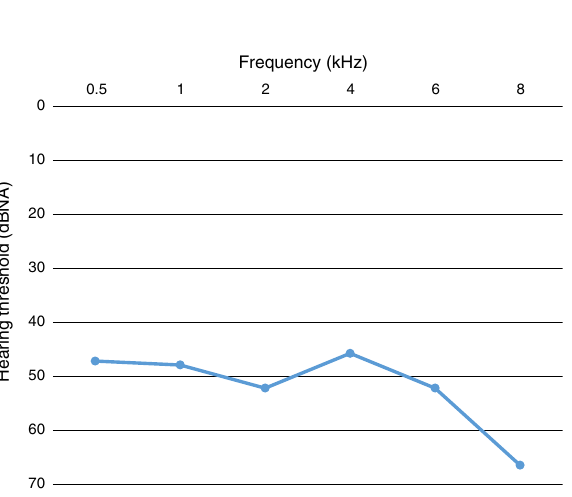
Figure 1 Profile of hearing loss according to average hearing threshold in frequencies.